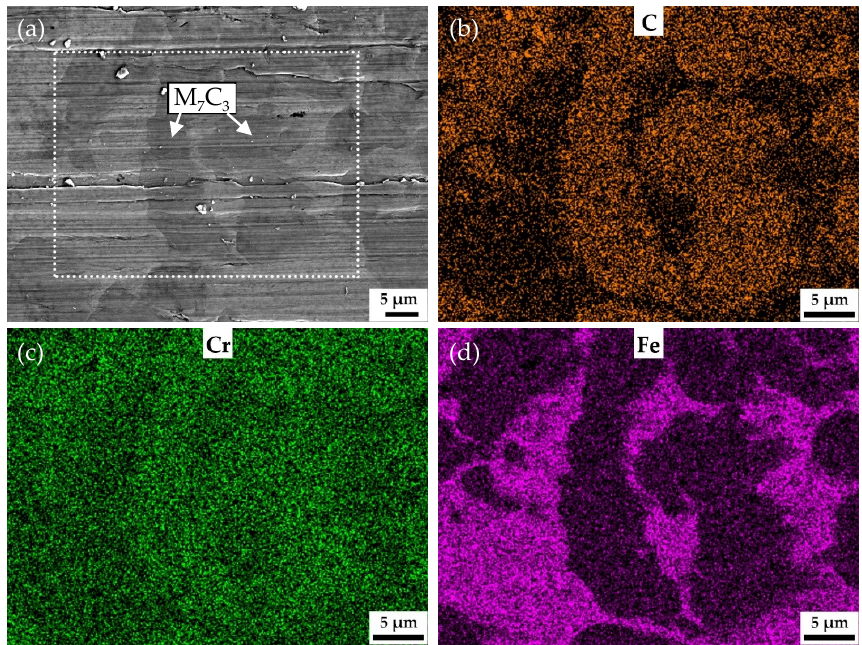
Figure 10. SEM and EDS mapping images of the surface of HCCI after abrasive wear test. The white dotted box is the area of EDS mapping. ( a ) SEM image, ( b ), ( c ) and ( d ) EDS mapping images of C, Cr and Fe, respectively.